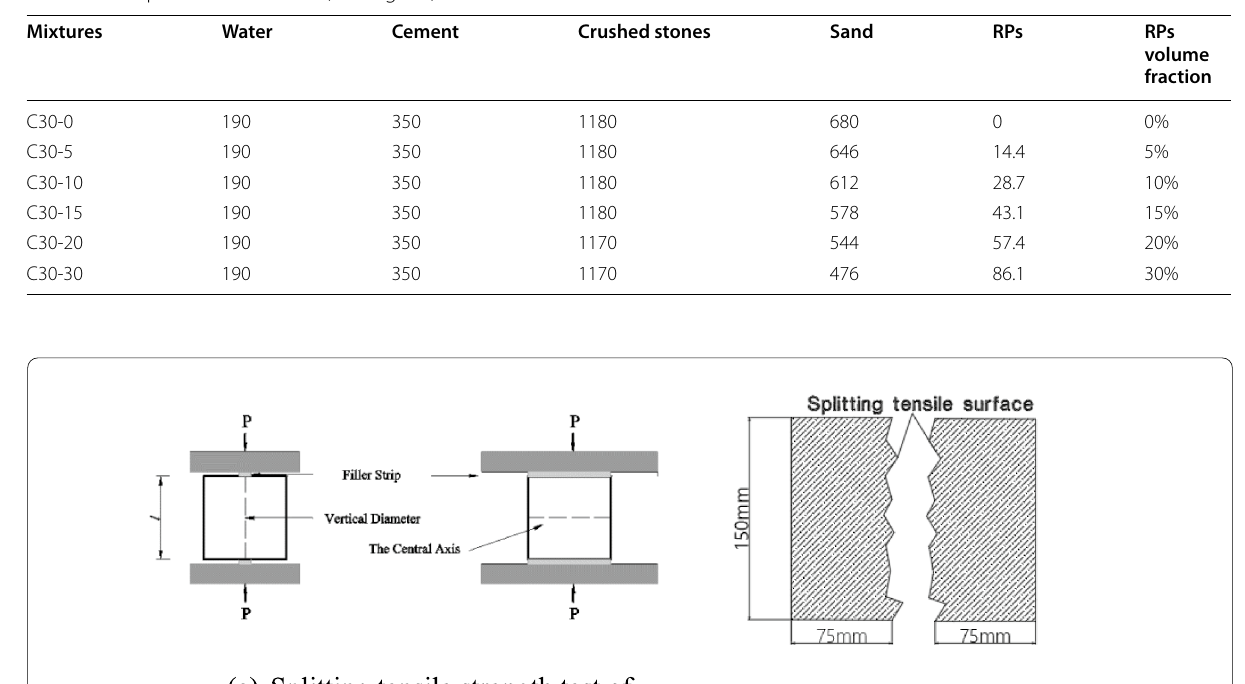
Table 3 Recipes of the concrete (unit: kg/m 3 ).